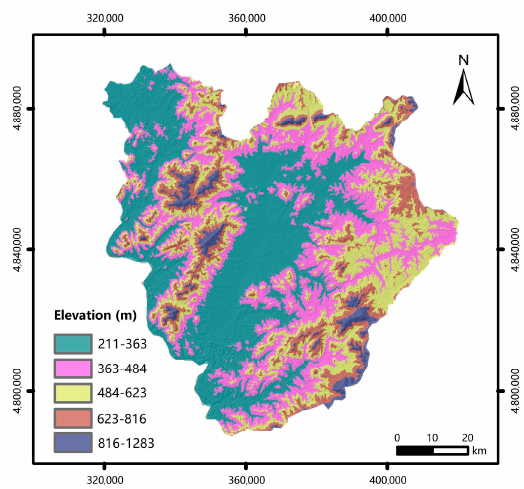
Figure 4. Digital Elevation Model (DEM) of Jiaohe County (m).